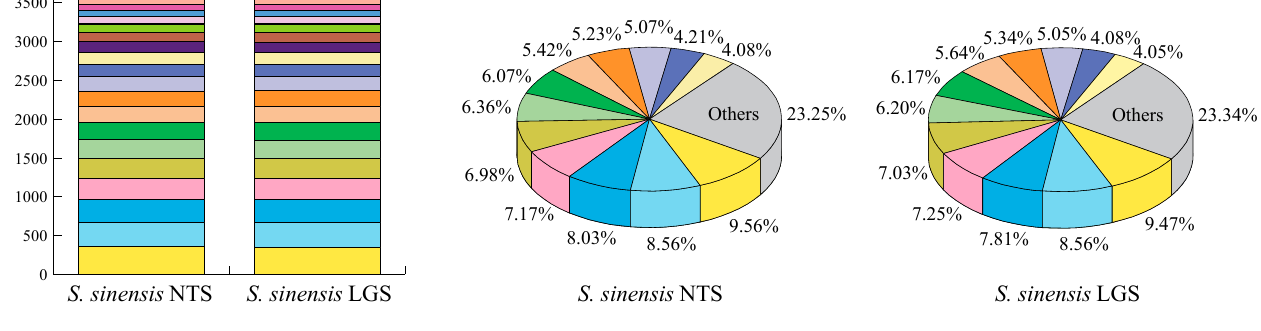
Figure 2. The number of different amino acids in the mt genomes of S. chinensis NTS and S. chinensis LGS. Different colors represent different amino acids. The left panel is a stacked histogram of the number of amino acid usages with decreasing frequency from bottom to top, and the right panel is a pie chart of the percentage of amino acid usages.